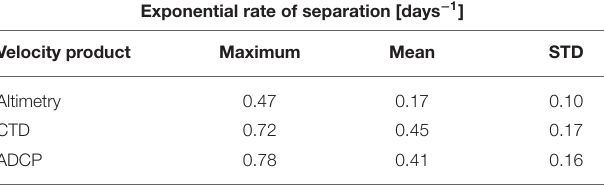
TABLE 2 | Maximum, mean, and standard deviation (STD) of the forward finite-size Lyapunov exponents of the altimetry-, CTD-, and ADCP-derived Lagrangian